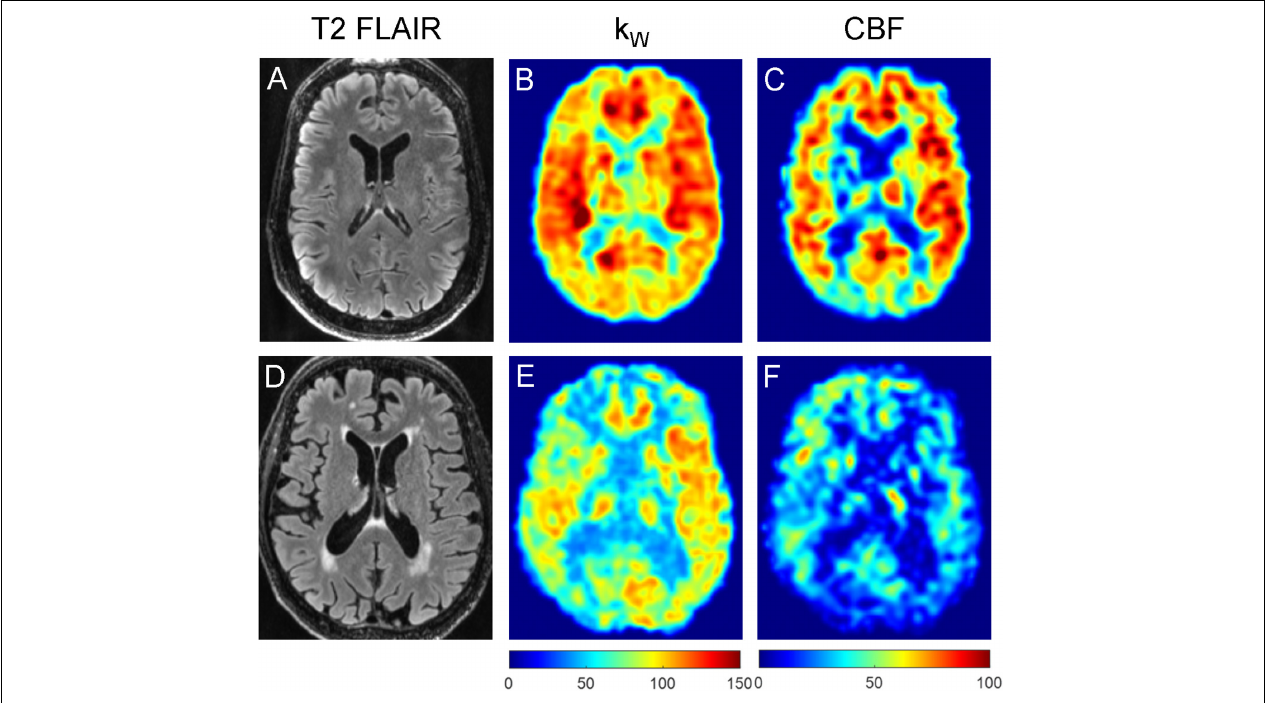
FIGURE 6 | Representative T2-FLAIR images (A,D) , k W maps (B,E) and CBF maps (C,F) obtained from a 76-year-old subject with no vascular risk factors and no significant WMH (A–C) , and a 74-year-old subject with two vascular risk factors (HTN, HLD) and moderate burden of WMH (D–F) . The subject without appreciable WMH demonstrated mean cortical k W of 98.4 min − 1 , mean white matter k W of 93.8 min − 1 , mean cortical CBF of 56.6 mL/100 g/min, and mean white matter CBF of 47.6 mL/100 g/min. The subject with moderate WMH burden (total WMH volume of 5,456 mm 3 ) demonstrated lower mean cortical k W of 72.6 min − 1 , mean white matter k W of 64.0 min − 1 , mean cortical CBF of 28.1 mL/100 g/min, and mean white matter CBF of 23.6 mL/100